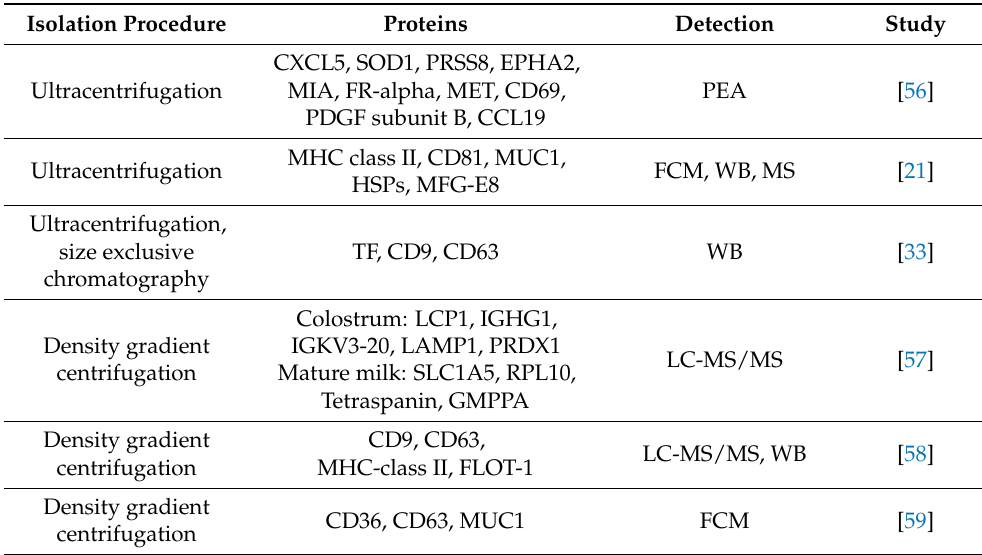
Table 2. Main proteins identified in isolated extracellular vesicles from human milk.